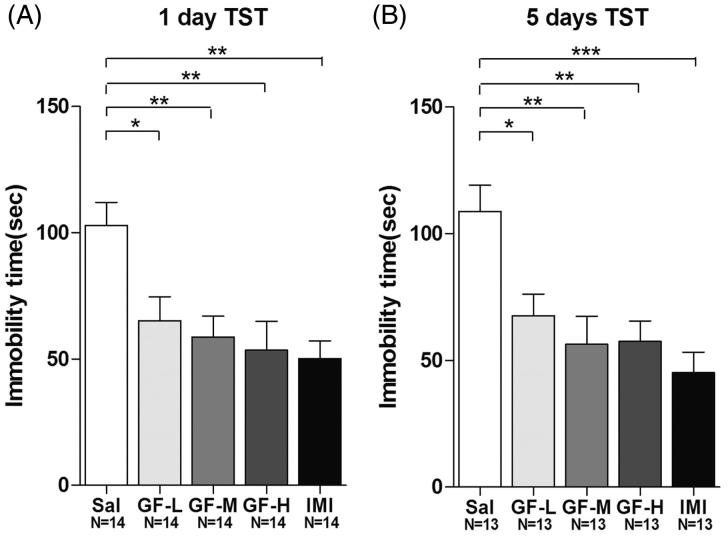
Griflola frondosa (GF) demonstrated significant antidepressant effects in the tail suspension test (TST). CD-1 mice were fed with regular mouse chow, a low dose of Griflola frondosa (GF powder:mouse chow =1:4, GF-L); a medium dose of Griflola frondosa (GF powder:mouse chow =1:2, GF-M); or a high dose of Griflola frondosa (GF powder:mouse chow =1:1, GF-H). For the positive control group, mice were i.p. injected with imipramine (15 mg/kg/day, IMI). Mice in the negative control group were i.p. injected with saline (Sal). One day or five days after the GF-treated food intake, mice were subjected to the TST. The number of mice per group is indicated in each individual graph. Data were analysed by one-way ANOVA and presented as the mean ± SE (post hoc Tukey’s test, *p < 0.05, **p < 0.01, ***p < 0.001). (A) One day after the administration, GF treatment significantly reduced the immobility time in the TST. (B) Five days after the GF administration, GF again significantly reduced the immobility time in the TST.